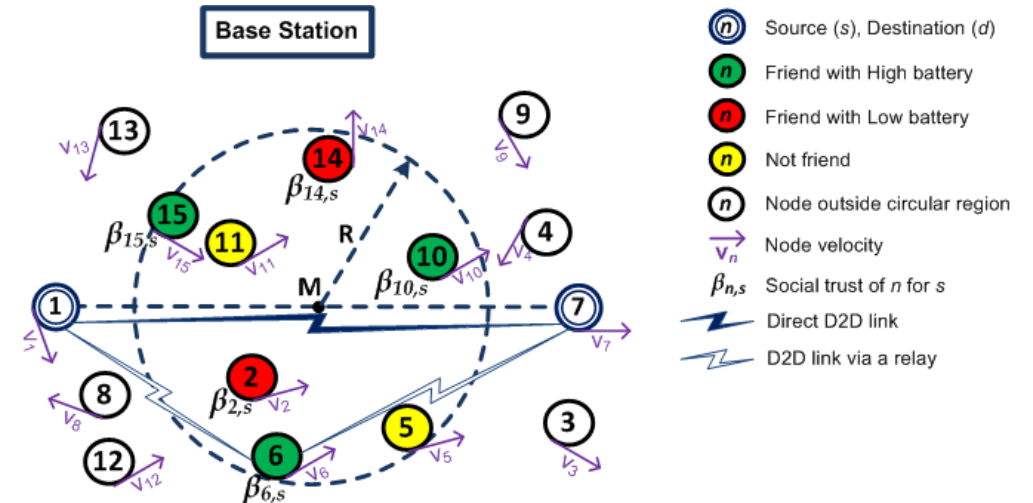
Figure 1. A system model for device-to-device (D2D)